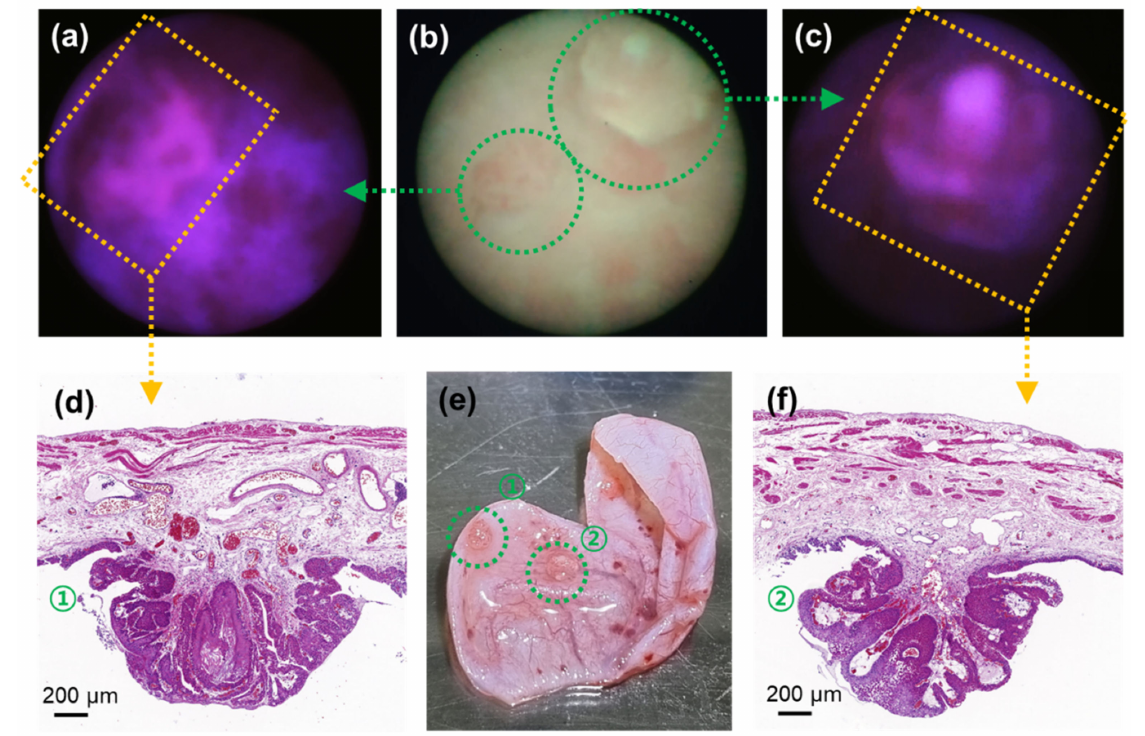
Figure 5. Biopsy process and H/E staining results of bladder cancer tissue at week 10 observed with brightfield and fluorescence imaging. ( a , c ) Two neighboring cancer lesions observed with fluorescence imaging and ( b ) corresponding brightfield image. ( d , f ) H/E staining results of the excised bladder cancer tissues. ( e ) Image of the excised bladder with the cancer lesions (highlighted in green dotted